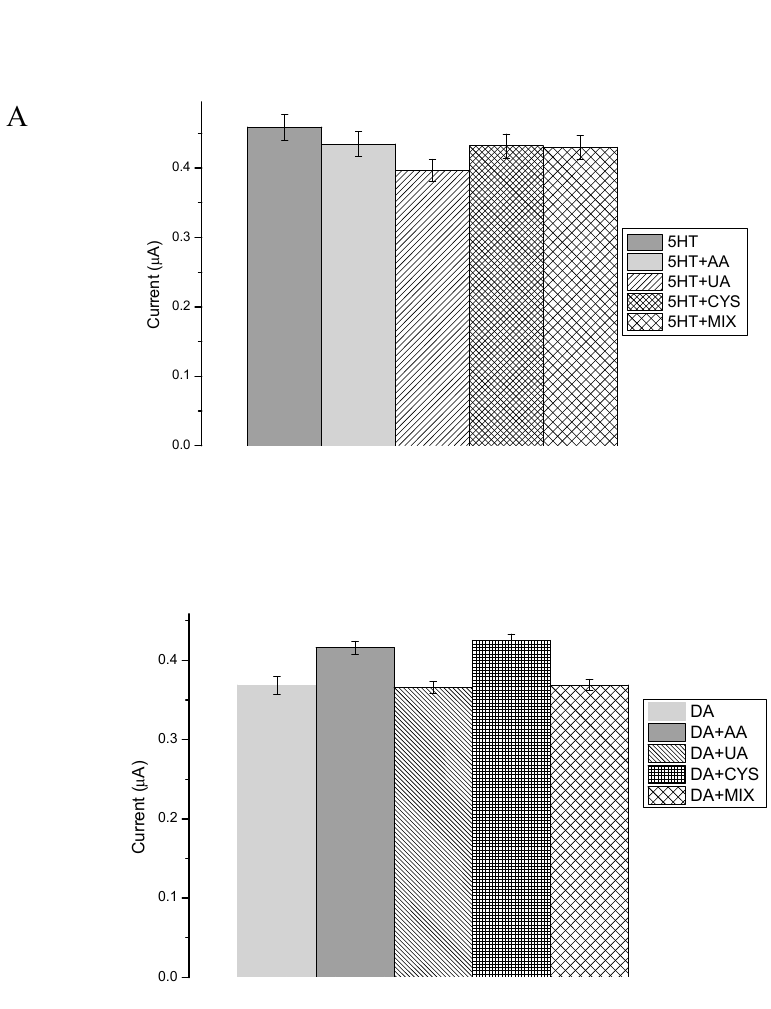
Figure 13. E ff ect of interfering substances (50 µ M) on 5-HT determination ( A ) and DA determination ( B Figure 13. Effect of interfering substances (50 μ M) on 5-HT determination ( A ) and DA determination ( B ).